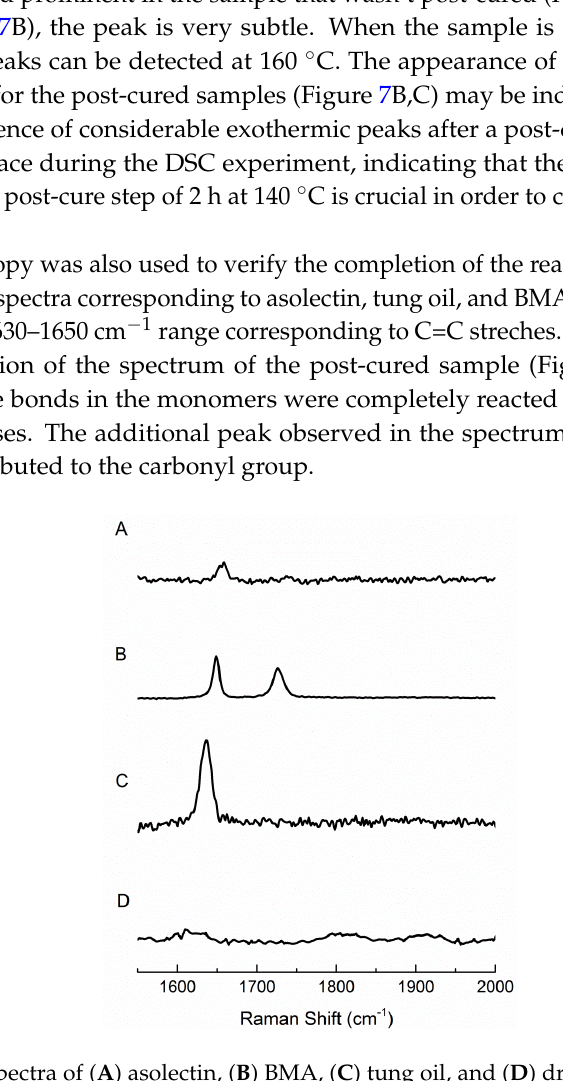
Figure 8. Raman spectra of ( A ) asolectin, ( B ) BMA, ( C ) tung oil, and ( D ) dried emulsion containing